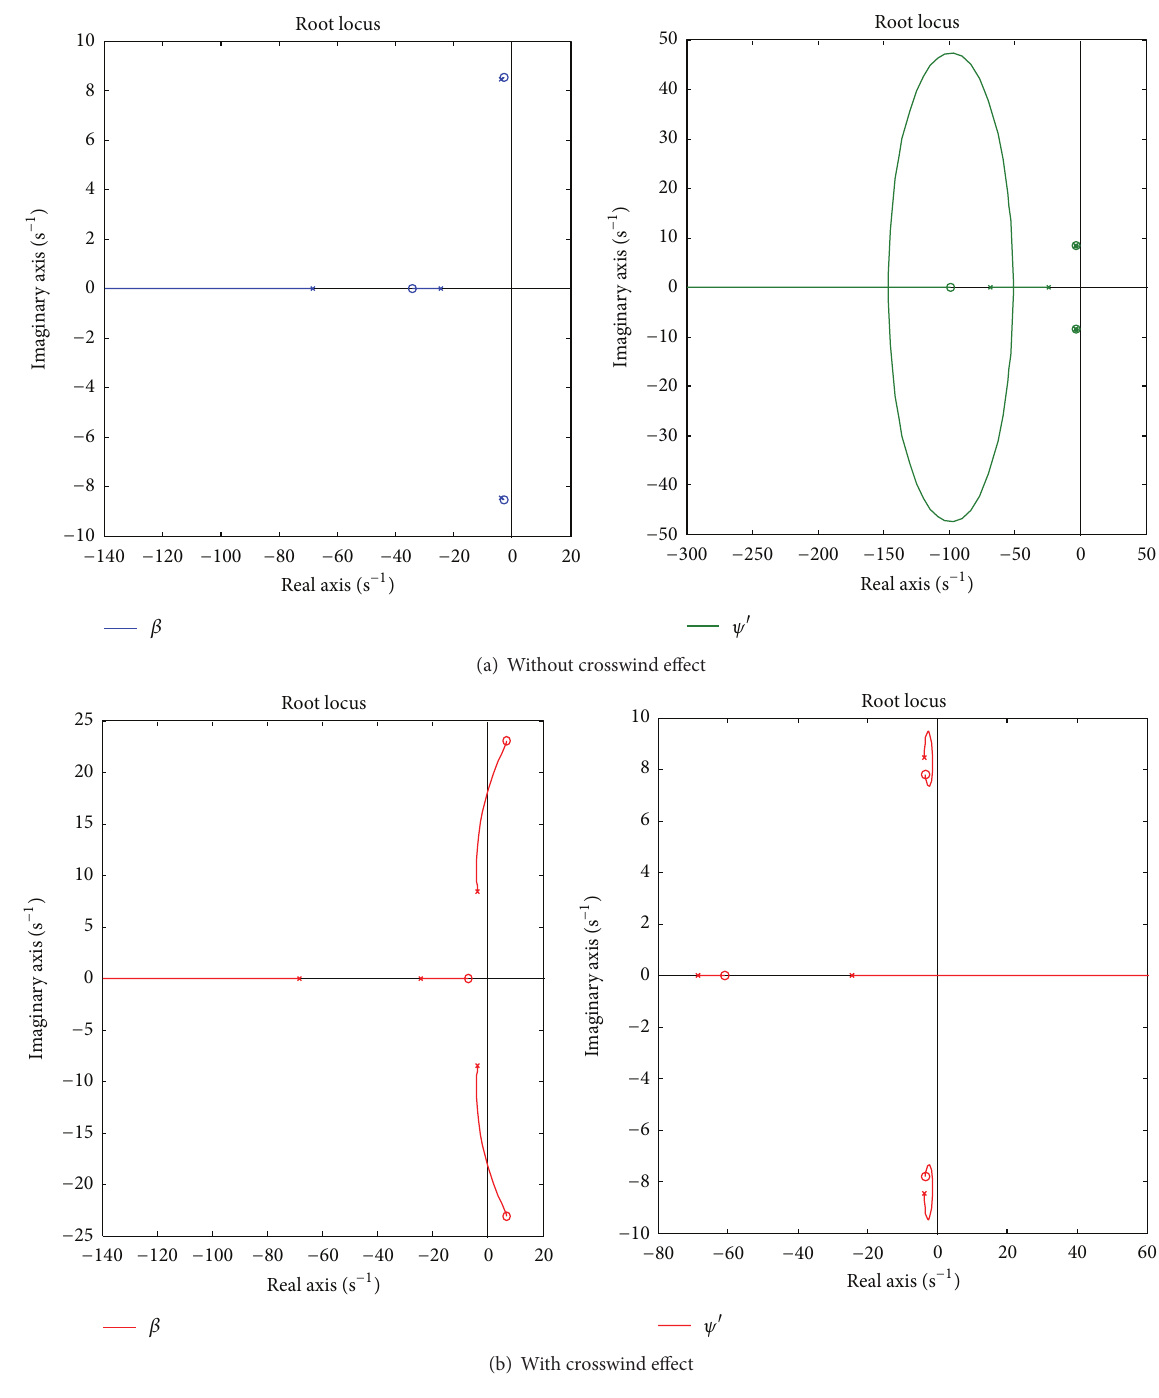
Figure 6: Open-loop system in